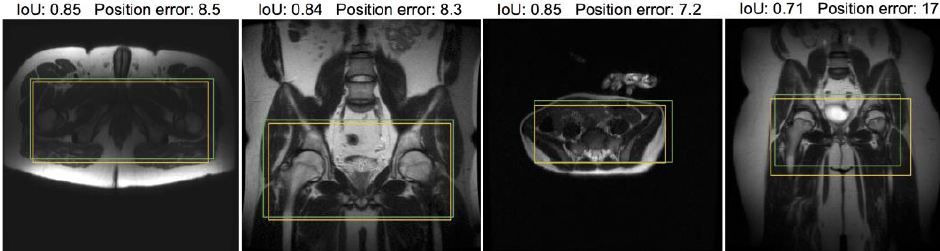
Figure 6. Samples from pelvic localizer test dataset annotated with intra-stack attention model-predicted ROI (yellow) and the ROI label given by radiologists (green). To help visually interpret the quantitative results, the IoU and position error for the model prediction in each example are included. Note that only one representative slice of a stack is shown, and neither ROI was determined merely from this slice. The left three samples are representative of the average model performance, while the rightmost example is a poorly performed case.